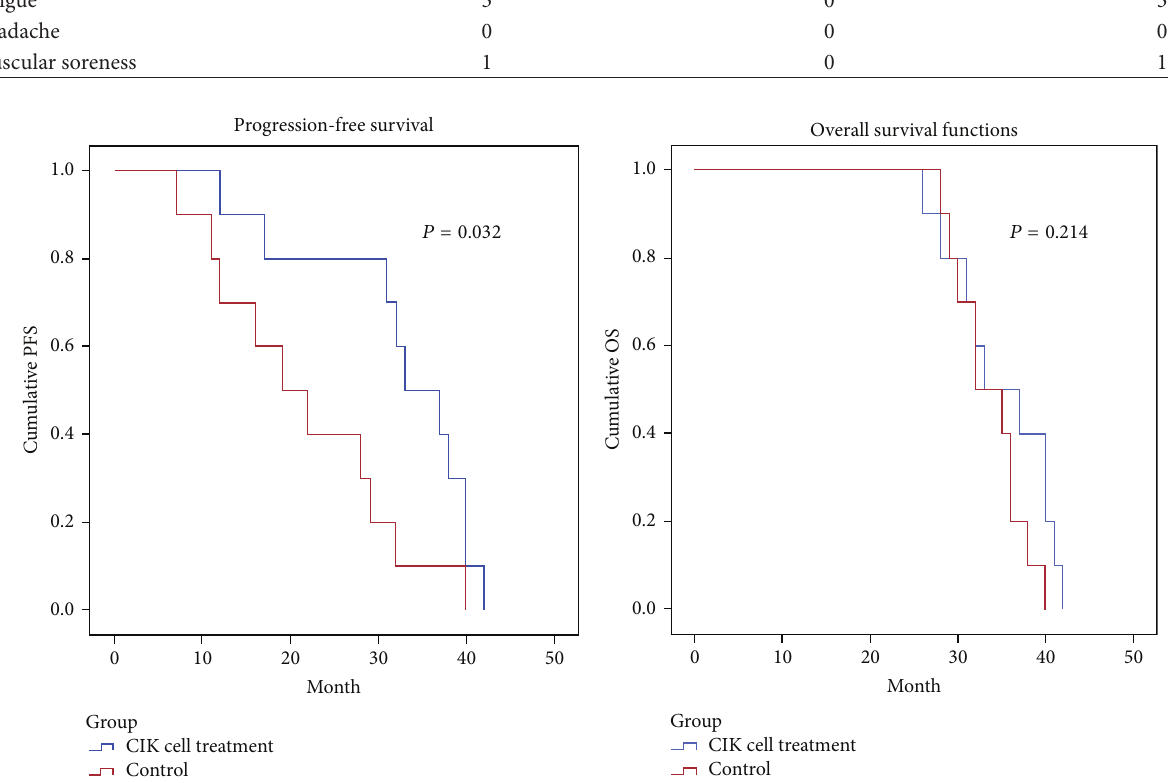
Figure 3: Kaplan-Meier estimates of progression-free survival (PFS) and overall survival (OS). Left figure: PFS. Blue line: CIK cell treatment group. Red line: control group. Log-rank: 𝑃 = 0.032 . Right figure: OS. Blue line: CIK cell treatment group. Red line: control group. Log-rank: 𝑃 = 0.214 ; all patients were alive during the course of followup, and there were no statistically significant differences between two groups in